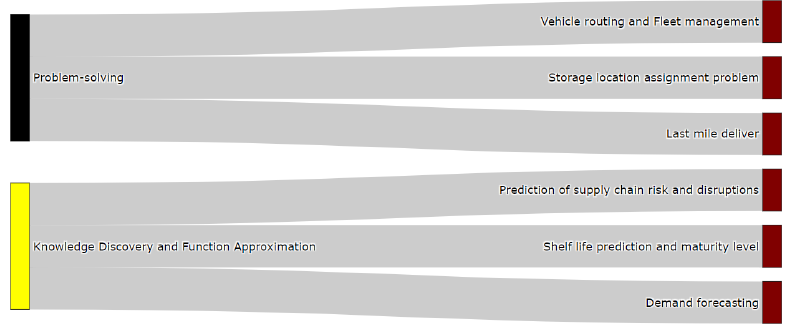
Figure 13. Distribution problems classified by the proposed